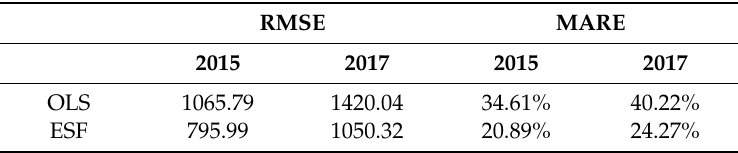
Table A8. LOOCV results of the OLS and ESF for vcmsl version NTL